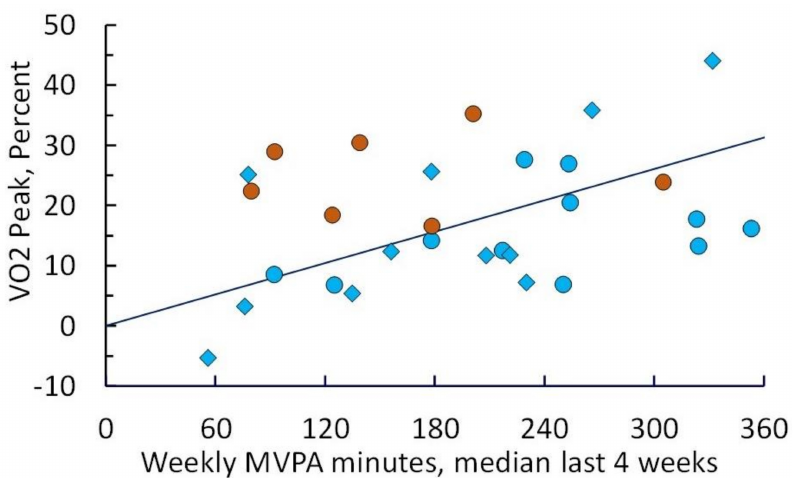
Figure 3. Improvement in cardiopulmonary fitness after 12 and 24 weeks of intervention as measured by peak oxygen consumption (VO 2peak ) relative to baseline, plotted as a function of weekly MVPA achieved (median of recorded values weeks 9–12 or weeks 21–24). Diamonds denote participants in cohort 1; circles denote participants in cohort 2 (blue = 12-week values; orange = 24-week values). Linear regression yields a slope of 0.057% change in VO 2peak per min of MVPA ( p = 0.021). MVPA was also associated with reduction in total mass and fat ( p ≤ 0.001), and VAT loss ( p = 0.015) at both 12 and 24 weeks. There was a linear correlation of VAT loss with MVPA (Figure 4), yielding a slope of 0.063% visceral fat loss per min of MVPA that was statistically significantly different than zero ( p = 0.011).